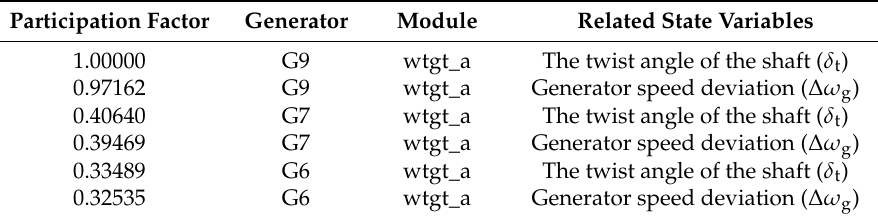
Table 5. Participating WTGs and state variables of the strong-interaction mode for the penetration level 50.17% in the NETS area.